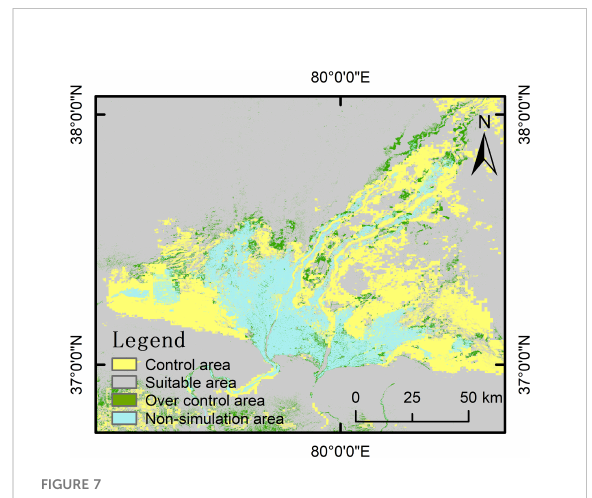
FIGURE 7 Spatial distribution of deserti fi cation combating areas. Control area is the area where deserti fi cation control is required; Suitable area is where the vegetation growth has reached the maximum growth potential allowed by the environment; Over contral area is where the vegetation growth exceeds the maximum growth potential allowed by the environment; Non-simulation area refers to irrigated cropland, impervious surface, and water body.